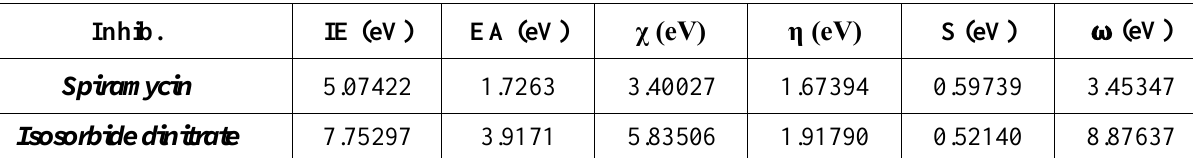
Table 4: The DFT approach was used to derive quantum chemical properties for the inhibitor molecule in a vacuum